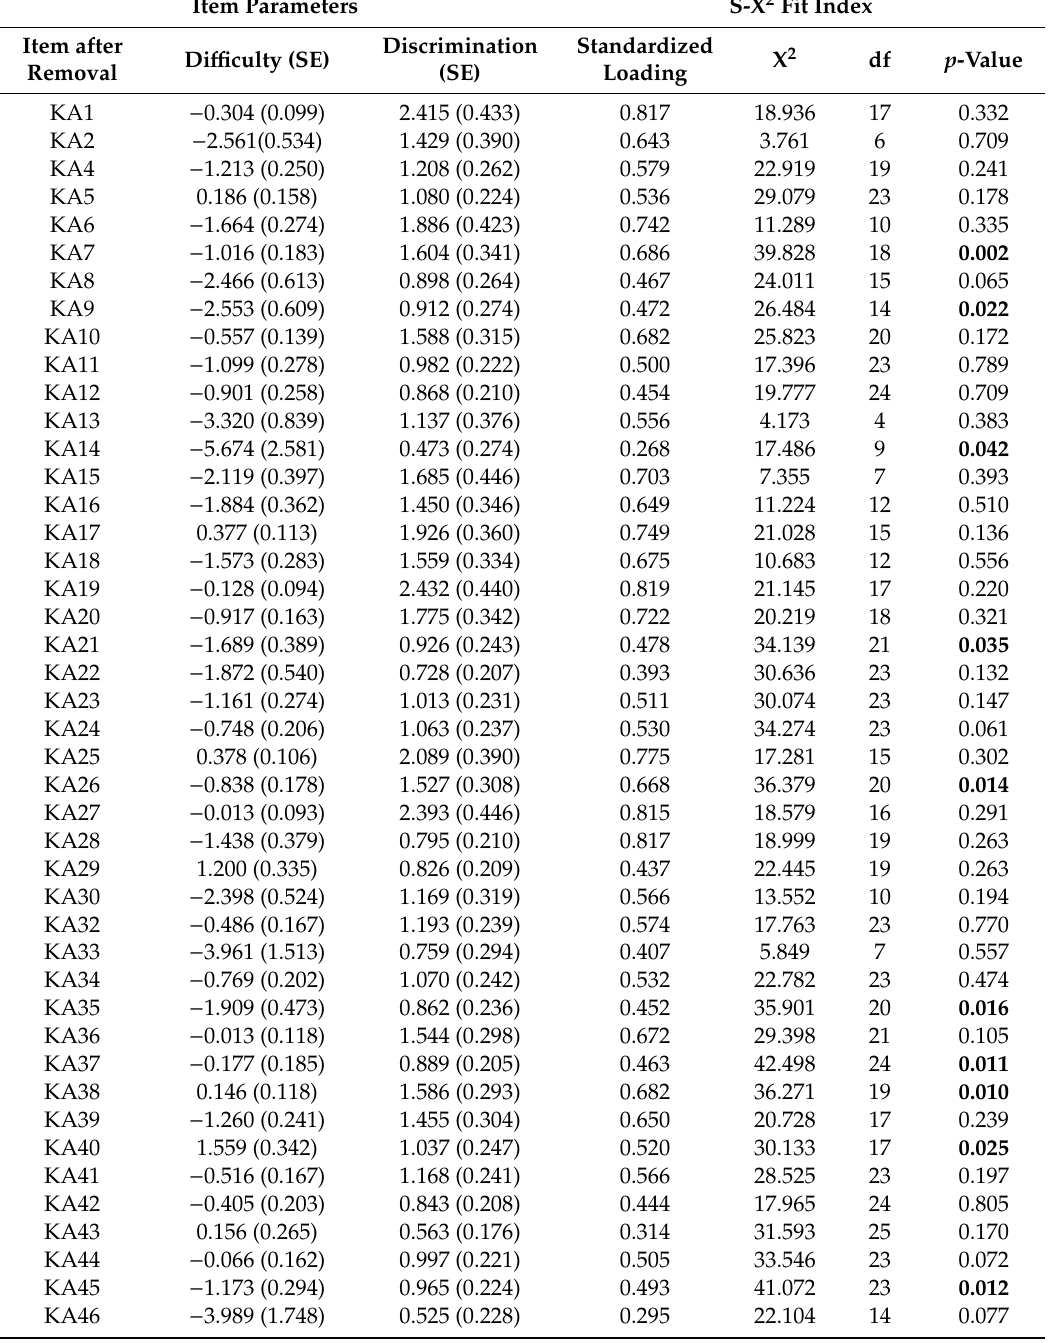
Table 3. Item response theory parameters estimate of items of knowledge in breastfeeding and